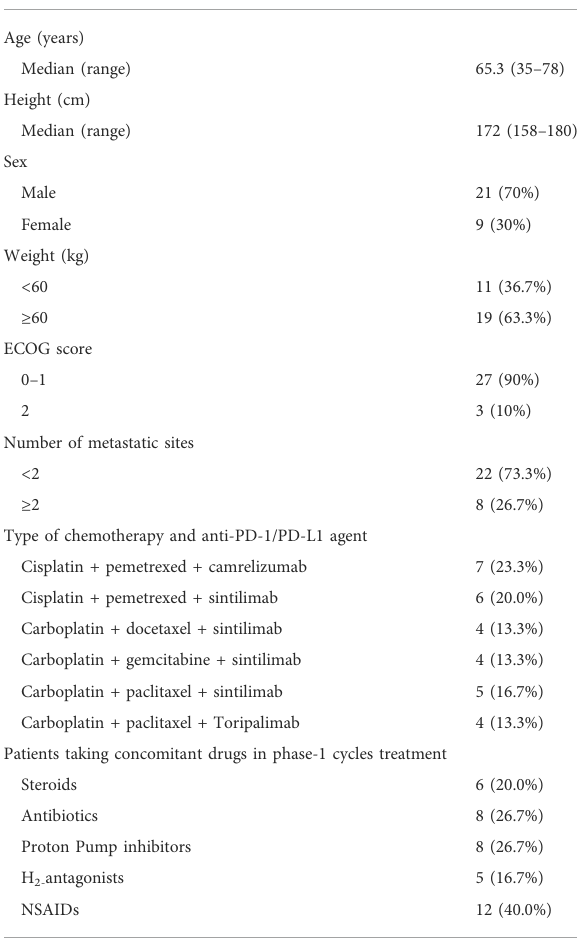
TABLE 1 The demographic and clinical characteristics of patients ( n =